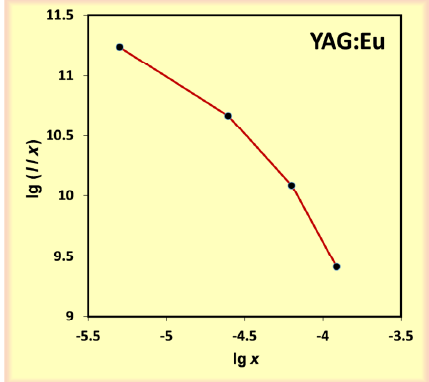
Fig. 9 PL intensity of the MD transition (592 nm): (a) as a function of the Eu 3+ dopant concentration in YAG, (b) as a function of the Si 4+ dopant concentration in YAG:Eu.